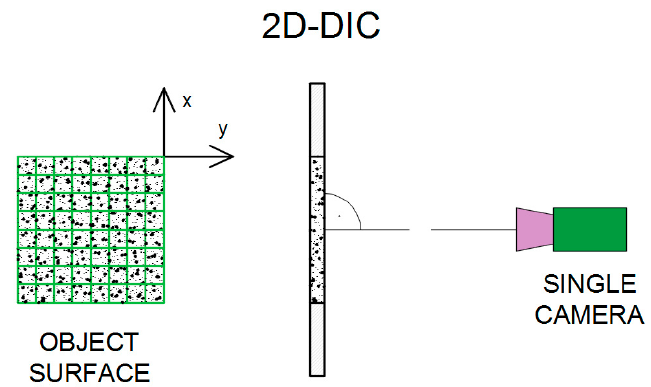
Figure 5. 2D-Digital Image Correlation system [17,18,20]. (The Creative Commons Attribution (CC BY 4.0) license (http: // creativecommons.org / licenses / by / 4.0 / )).